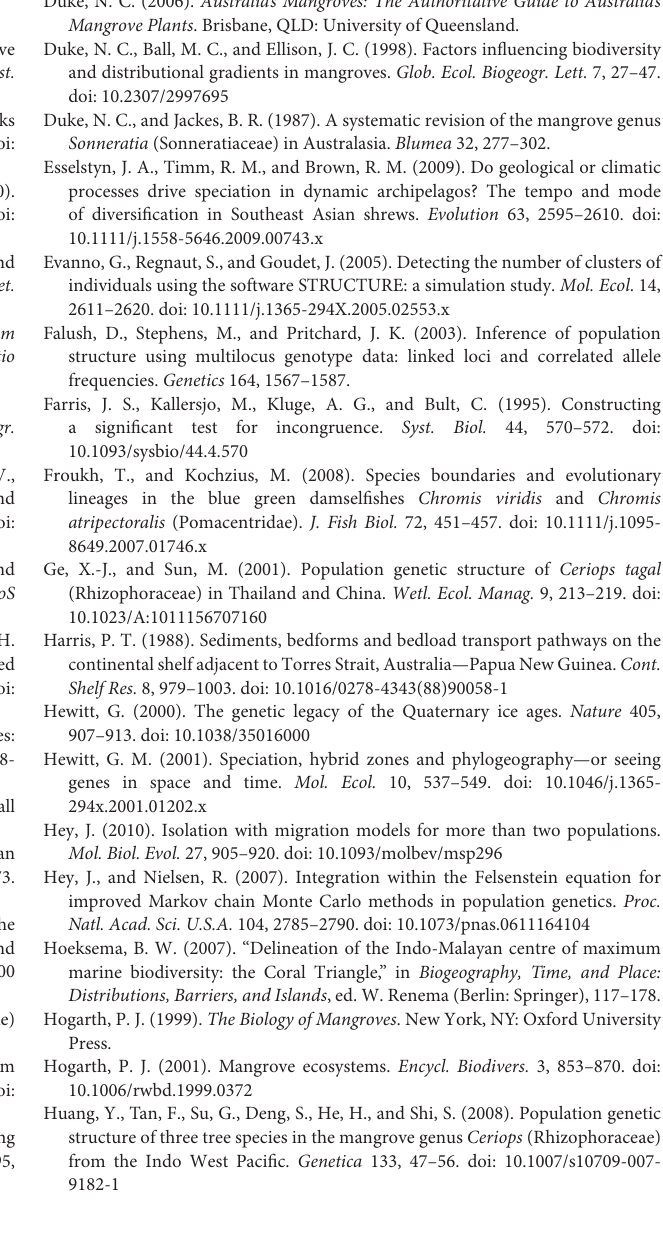
TABLE S2 | GenBank accession numbers of the sequences of the nuclear ribosomal internal transcribed spacer (nrITS) and the nuclear gene rpl9 for the six Sonneratia species and the outgroup D. grandiflora used in this study. TABLE S3 | Statistics of the combined chloroplast fragments and the five nuclear genes for the populations of S. caseolaris and S. lanceolata . Population IDs are defined in Table 1 . S, the number of segregating sites; h, the number of haplotypes; Hd, haplotype diversity; θπ , nucleotide diversity; θ w, DNA polymorphism. TABLE S4 | Means and standard variations (SD) of pairwise K XY values of the five nuclear genes among the 13 populations of S. caseolaris